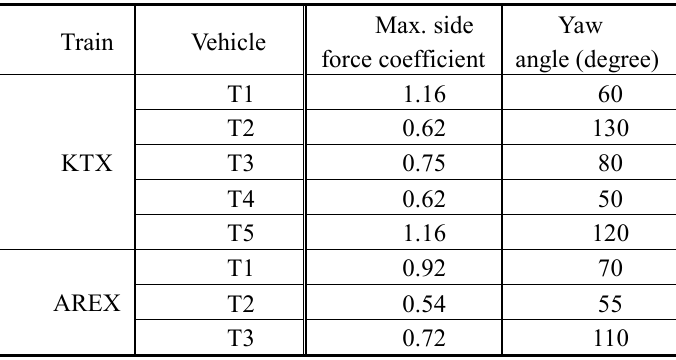
Table 2 Maximum side force coefficient